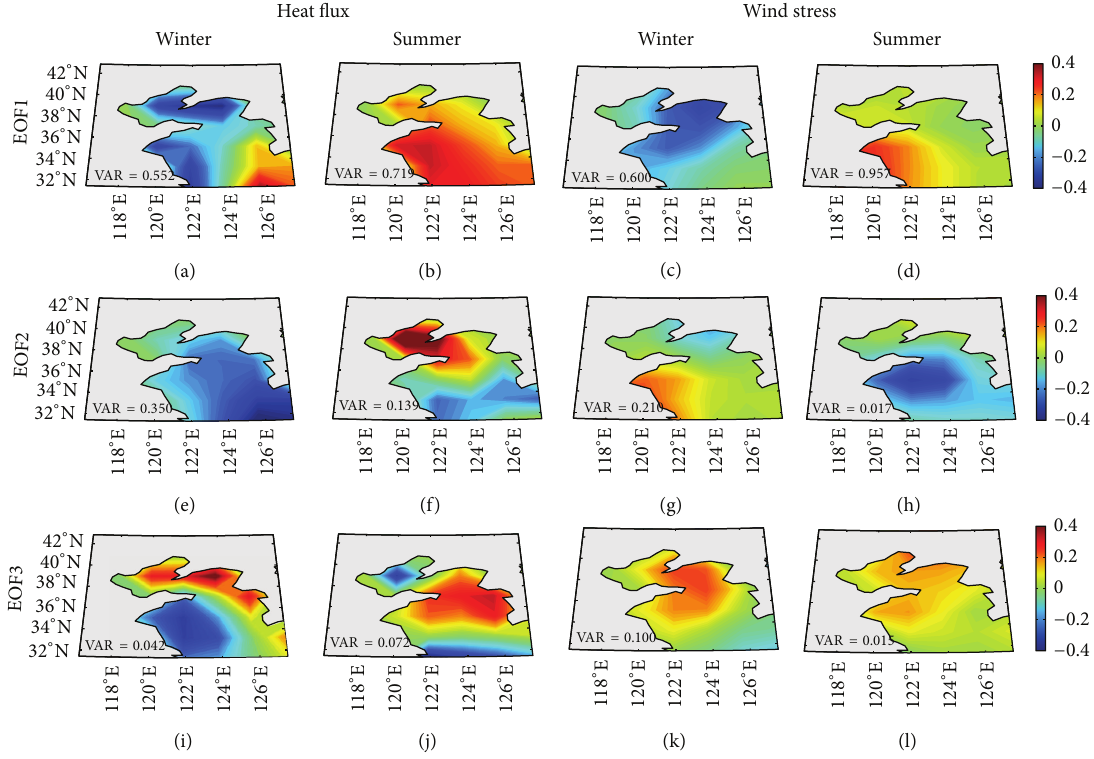
Figure 9: EOF1, EOF2, and EOF3 of decadal components for winter heat flux ((a), (e), and (i)) and summer heat flux ((b), (f), and (g)), winter wind stress ((c), (g), and (k)), and summer wind stress ((d), (h), and (l)). Positive values indicate that heat is transferred from the ocean to the atmosphere. Table 4: Correlation coefficients between EOF1, EOF2, and EOF3 of winter heat flux, wind stress, and winter AO, ENSO, and PDO, including the interannual and decadal components. Bold texts indicate that the correlations are statistically significant at the 95% confidence